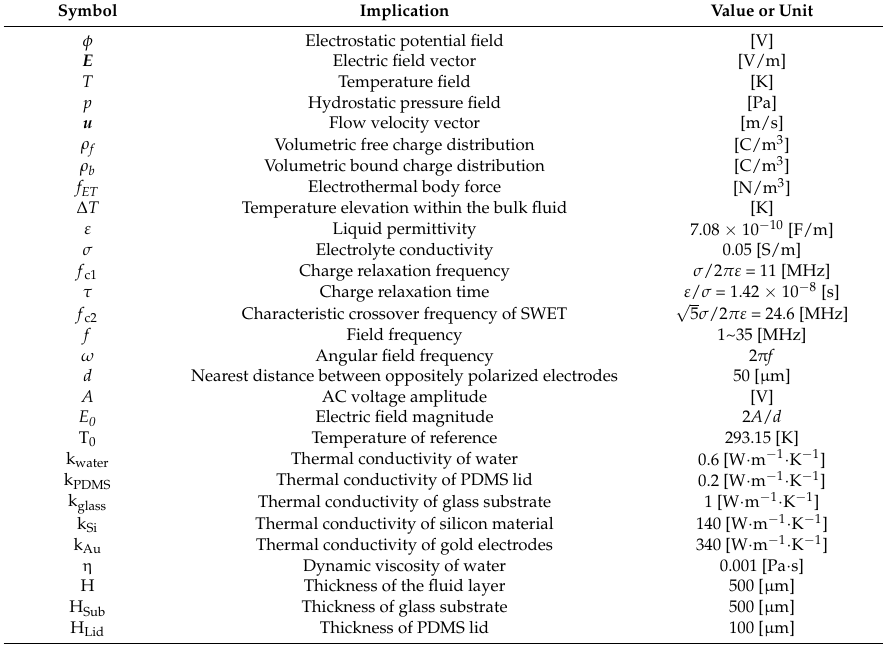
Table 1. Nomenclature of mathematical symbols invoked in this